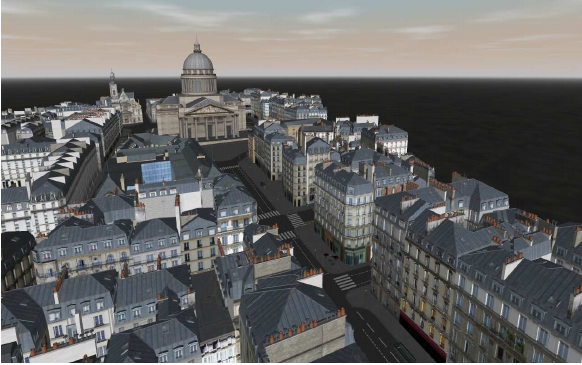
Fig. 3. Area around Pantheon in the 5th district of Paris. (a) registration : combination of the best results of ICP-SA , R-ICP and HPS-ICP .